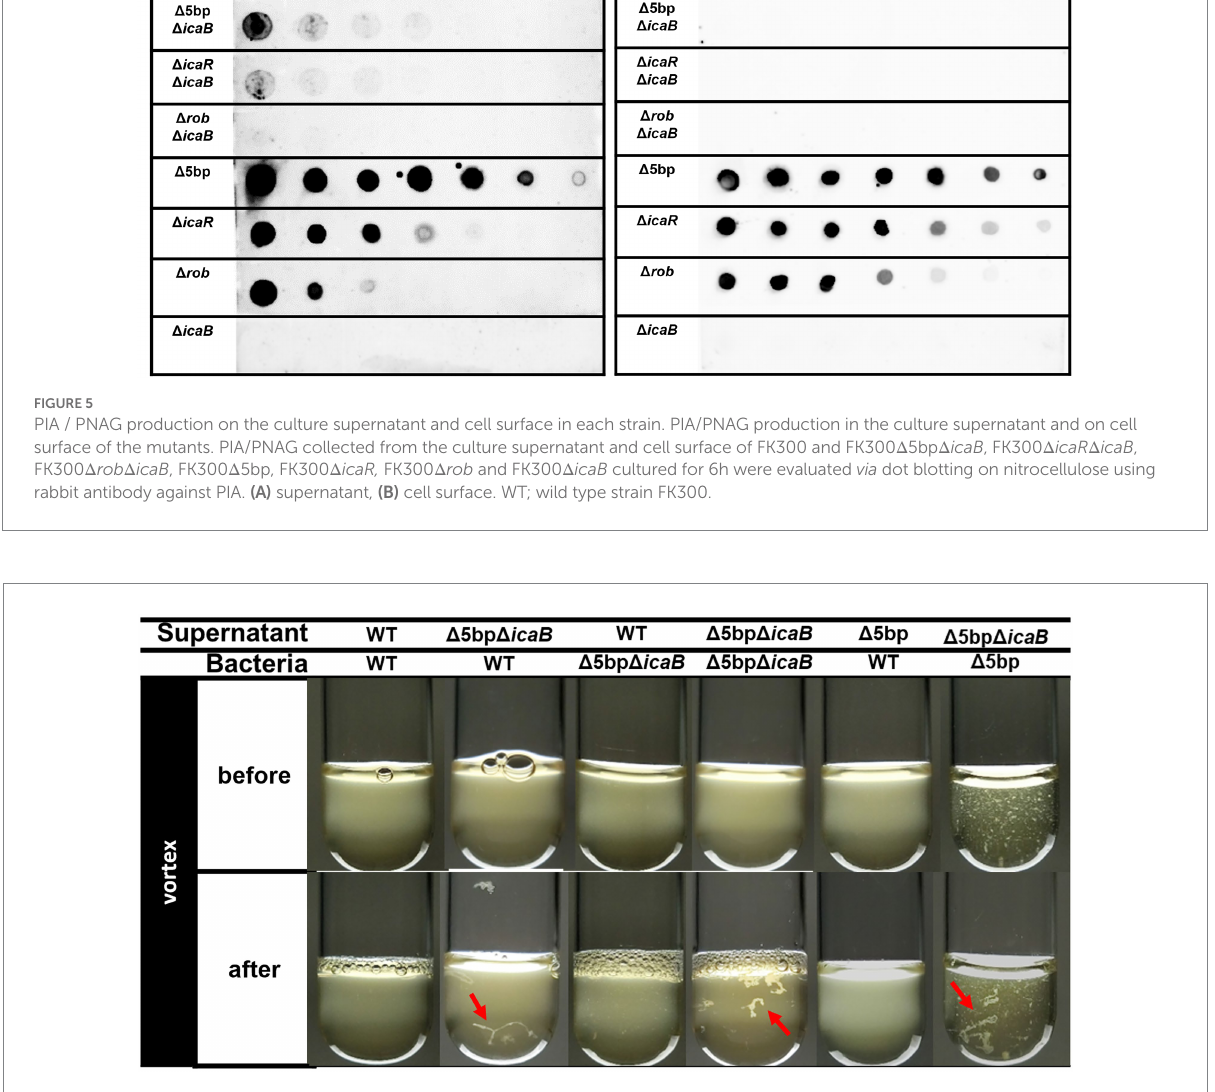
FIGURE 6 Swapping experiment of culture supernatant and bacterial cells. Swapping of culture supernatant and bacterial cells. Filtered culture supernatant of FK300, FK300 Δ 5bp, or FK300 Δ 5bp Δ icaB was incubated with bacterial cells of FK300 or FK300 Δ 5bp Δ icaB (before) and vortexed for 10 s (after), and photographic images of the culture were obtained. Aggregates identified after vortexing were indicated by red arrows. WT; wild type strain